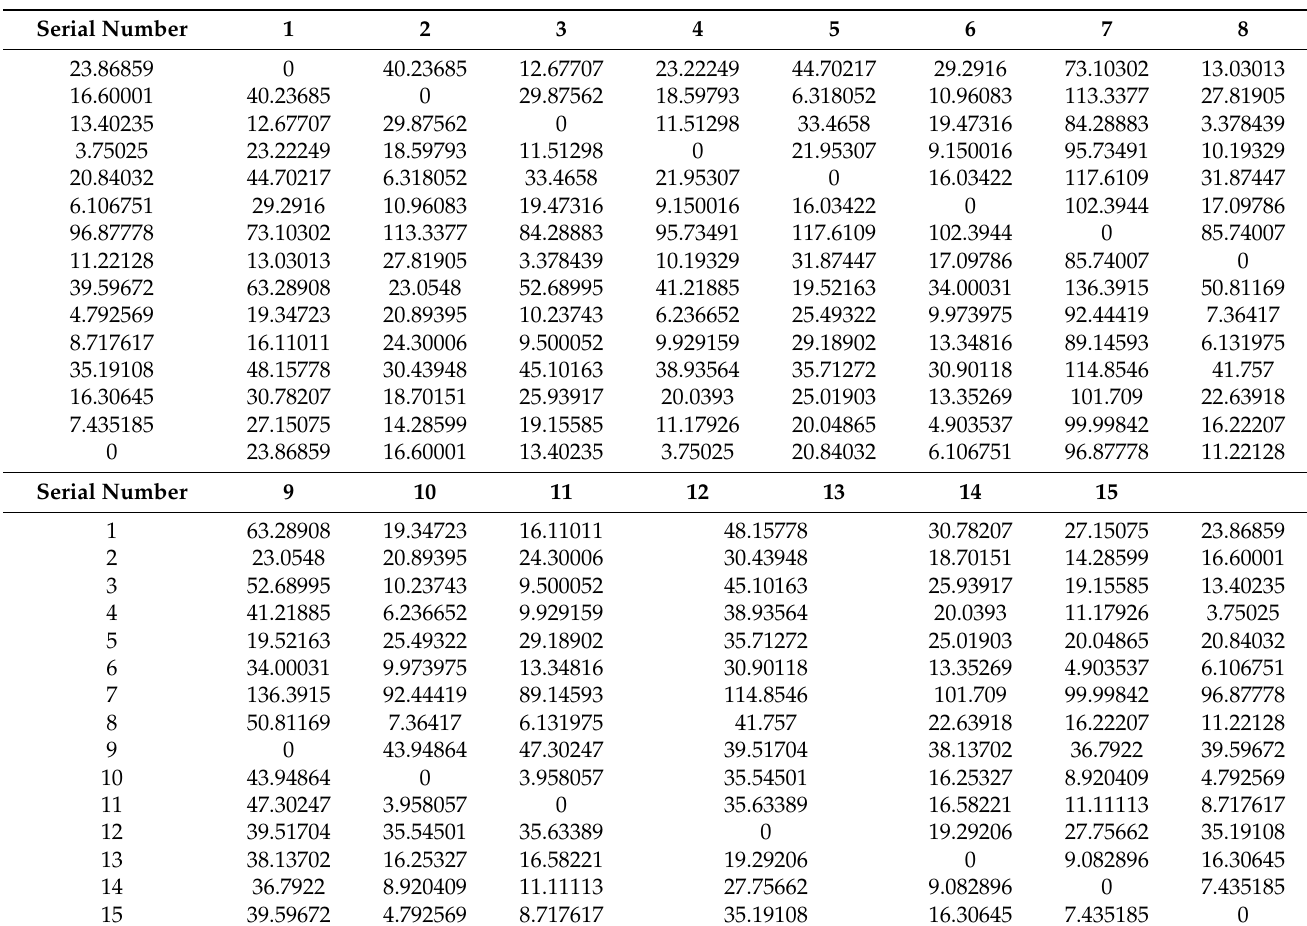
Table 6. Distance between candidate